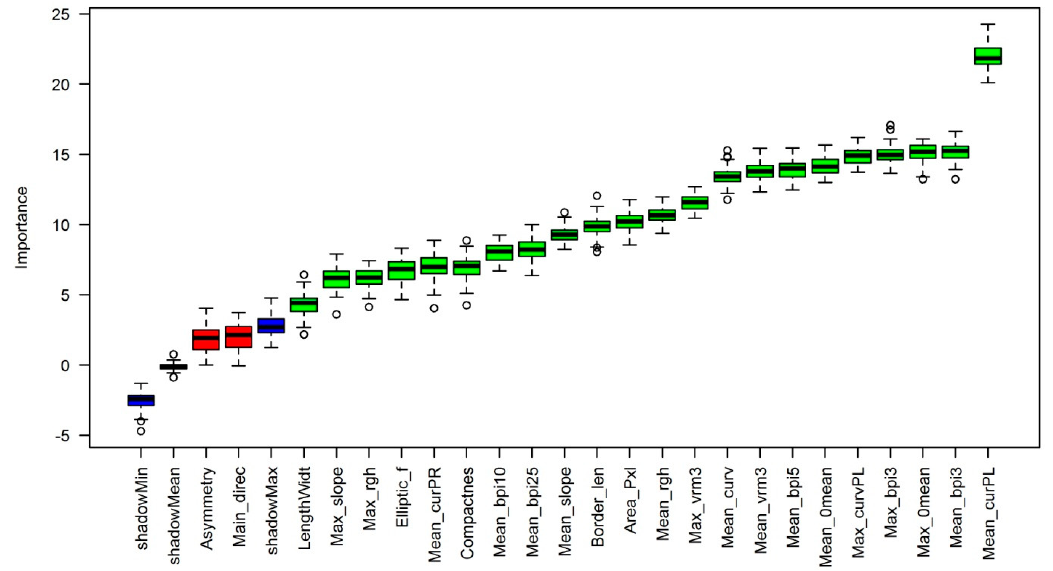
Figure 3. Results of the Boruta feature selection analysis. Green colours indicate important features, red colours indicate unimportant features. Shadow features are shown in blue.